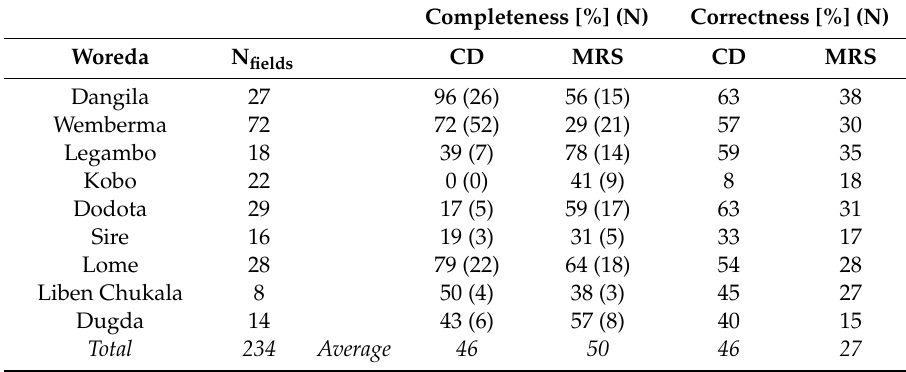
Figure 8. REF boundaries ( a ) and outputs from the two boundary detection methods, CD ( b ) and MRS ( c ), for one 1 km × 1 km tile in the Amhara Region. Image taken on 25 April, 2011. Imagery © 2011 DigitalGlobe, Inc. Table 2. The quantitative completeness and spatial correctness of the manual versus object-based automated field boundary mapping techniques for a representative image tile in each Woreda.